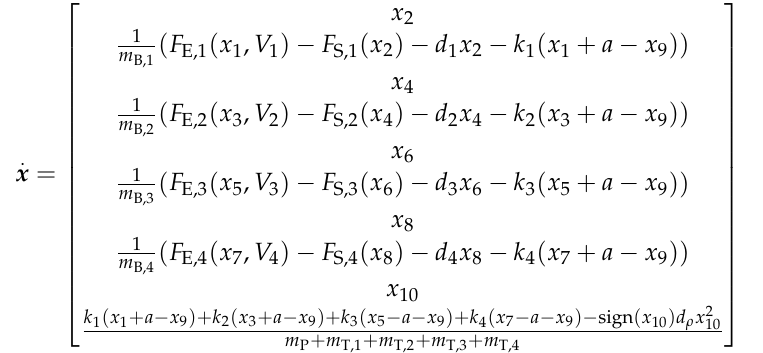
( c ) Figure 18. ( a ) Actuation scheme for every liquid bearing. Five control electrodes were switched on (red) sequentially for 85 ms at 42 V;( b ) voltage input timing sequence.. First period guaranteed a stable initial position of the moving platform. ( c ) Platform displacement in x -direction. Displace- ment was measured at the front side of the platform (cf. Figure 19). Figure 19. Three positions of the moving platform at 40 V with a switching period of t = 100 ms. 3.3.2. Multistability Unfortunately, the described scheme exhibited a disadvantage: if no voltages are ap- plied, the droplets on the non-we tt ing surface tend to roll o ff the electrode area if there is any kind of tilt of the electrode substrate. Therefore, it is necessary to “ fi x” the droplets in